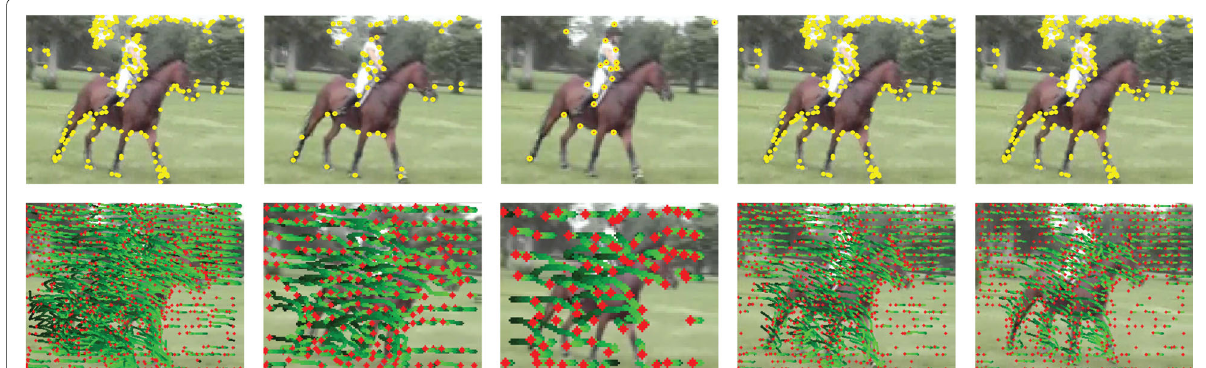
Fig. 4 Response of detectors when videos are downsampled spatially and temporally. Videos on the first row are using Harris3D detector and videos on second row are using warped flow estimation based feature tracking. The videos in columns 1, 2, and 3 represents the baseline, half resolution of the baseline, and one-third resolution of the baseline, respectively, while columns 4 and 5 represents one-half and one-third frame rate of baseline, respectively